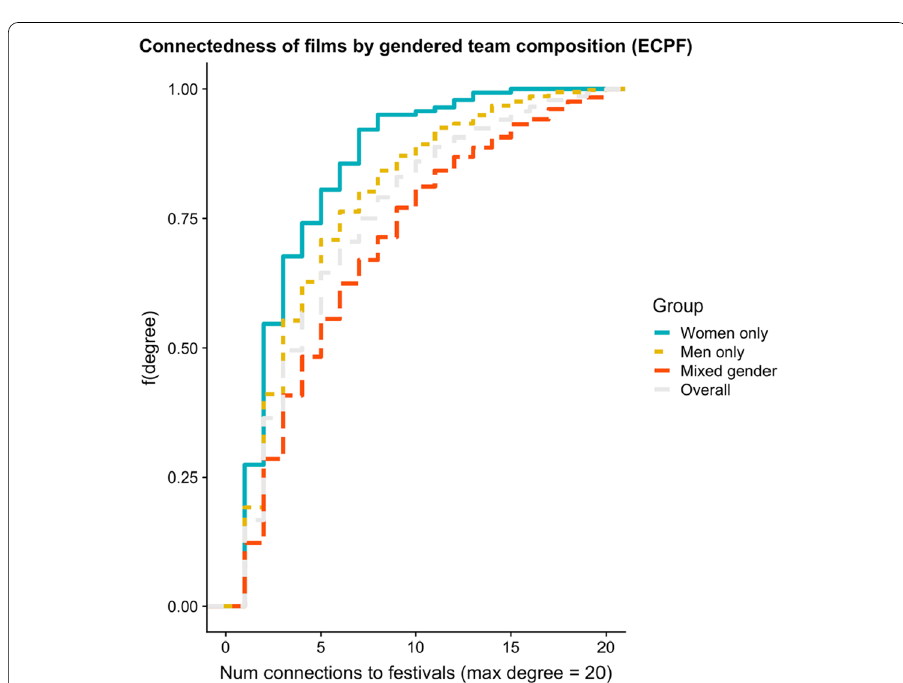
Fig. 10 Cumulative connectedness of films to festivals by gendered film core creative team composition based on cumulative density function of degree centrality. Note : The blue line indicates the cumulative connectedness for films made by women-only core creative teams. The yellow line indicates the cumulative connectedness for films made by men-only core creative teams. The red line indicates the cumulative connectedness for films made by mixed core creative teams. and the grey line indicates the cumulative connectedness for all films regardless of gendered film core creative team composition. Each line indicates for any given number of connections to festivals the percentage of films that are below that threshold. For example, about 75% of films made by women-only core creative teams are shown at most at 5 festivals. About 75% of films made by men-only core creative teams are shown at most at 7 festivals. Note that for improved graphical display the distributions are cut at a max degree of 20